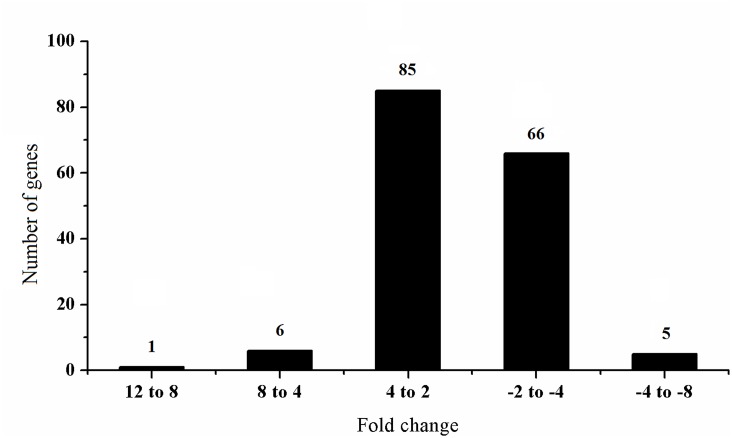
Distribution of the latex genes significantly regulated by ET stimulation in rubber trees.The fold-changes of gene expression were analyzed by cDNA microarray. The positive and negative numbers on the x-axis represented up- and down-regulation of latex genes, respectively.